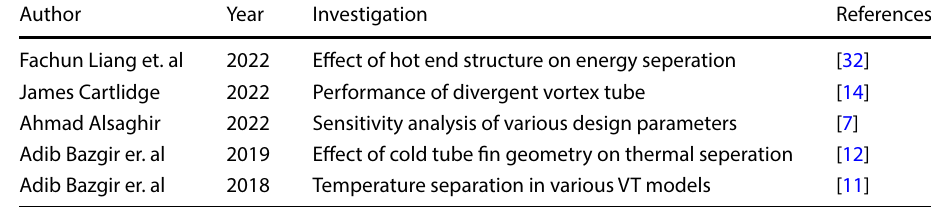
Table 1 Some numerical investigations on vortex